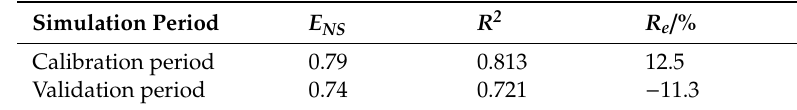
Table 3. Evaluation of the simulation results of monthly runo ff during the calibration and validation periods at Guantai station.